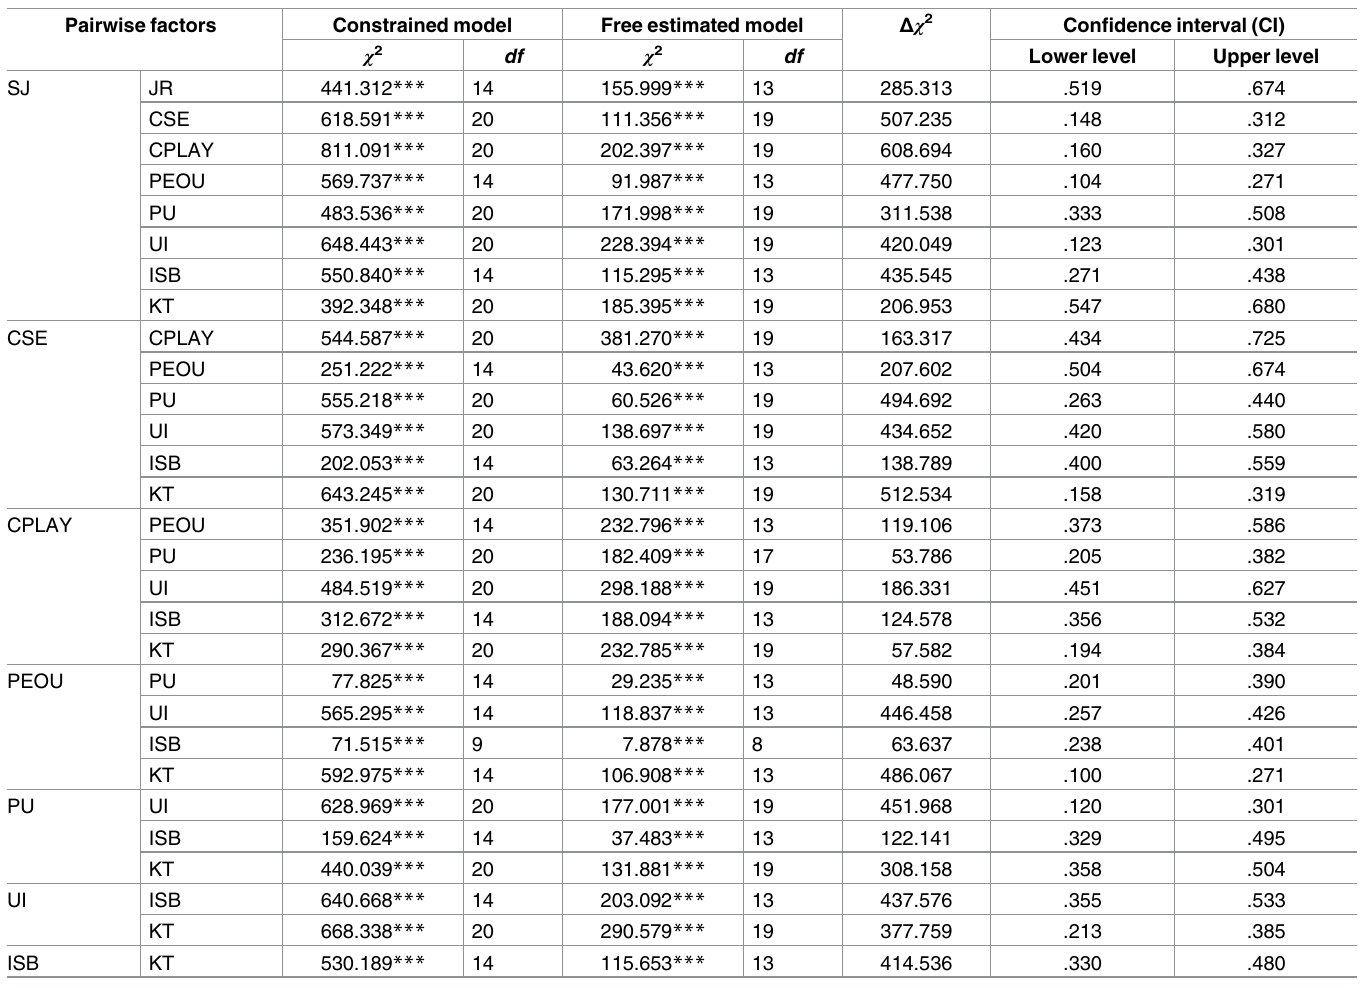
Table 2. Summaryof discriminant validity verification